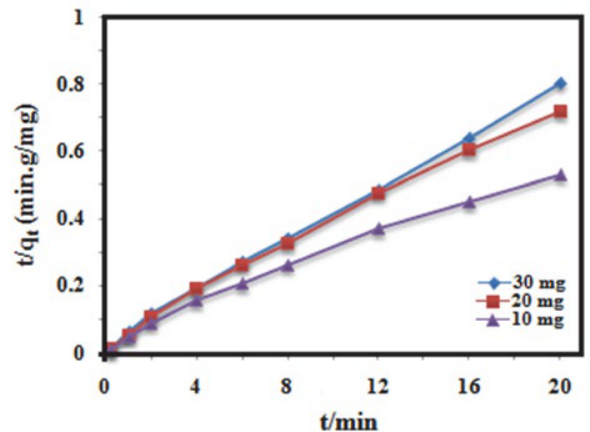
Figure 12. Pseudo-second-order kinetics plot of MB adsorption on GO/Co O nanocomposite. 3 4